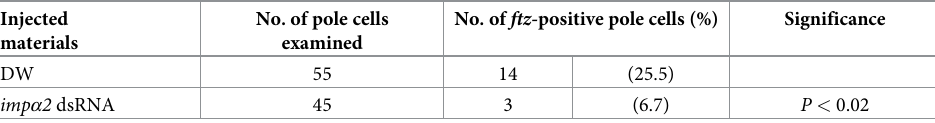
Embryos derived from pgc/Df; nos/nos females mated with y w males were injected with distilled water (DW) or dsRNA against imp α 2 RNA at the cleavage stage. The injected embryos were allowed to develop until stage 4–6, and were stained for ftz mRNA. Six and five embryos injected with DW and dsRNA were examined, respectively. Significance was calculated using Fisher’s exact